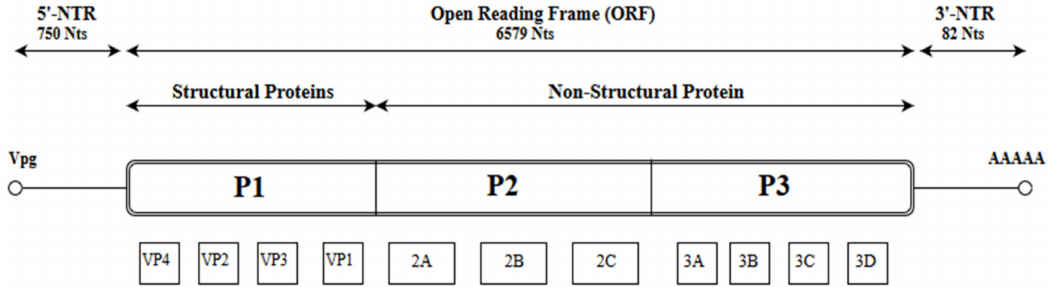
Figure 1. Schematic representation of the EV-A71 genome (7.4 Kb). The position of the VPg primer is shown at the 5 (cid:48) NTR end of the genome; the Open Reading Frame (ORF) contains the structural viral protein P1 which is cleaved to yield VP1, VP2, VP3 and VP4, and non-structural viral proteins P2 (cleaved to yield 2A, 2B and 2C) and P3 (cleaved to yield 3A, 3B, 3C and 3D). The 3 (cid:48) NTR end of the genome contains the poly (A)